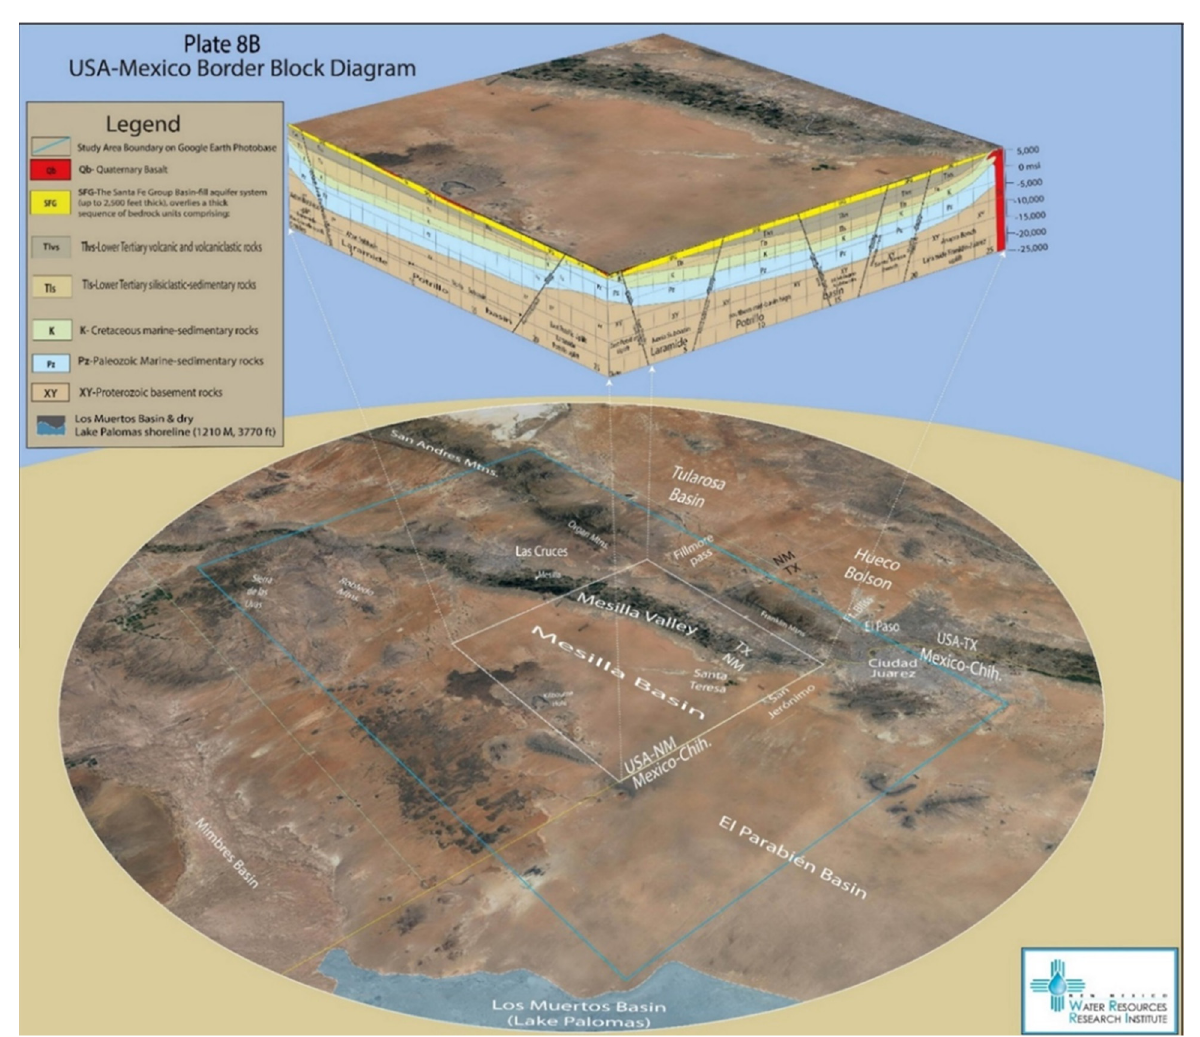
Figure A1. Northeast-facing block diagram of the southern Mesilla Basin, with its southern panel at the International-Boundary [35].